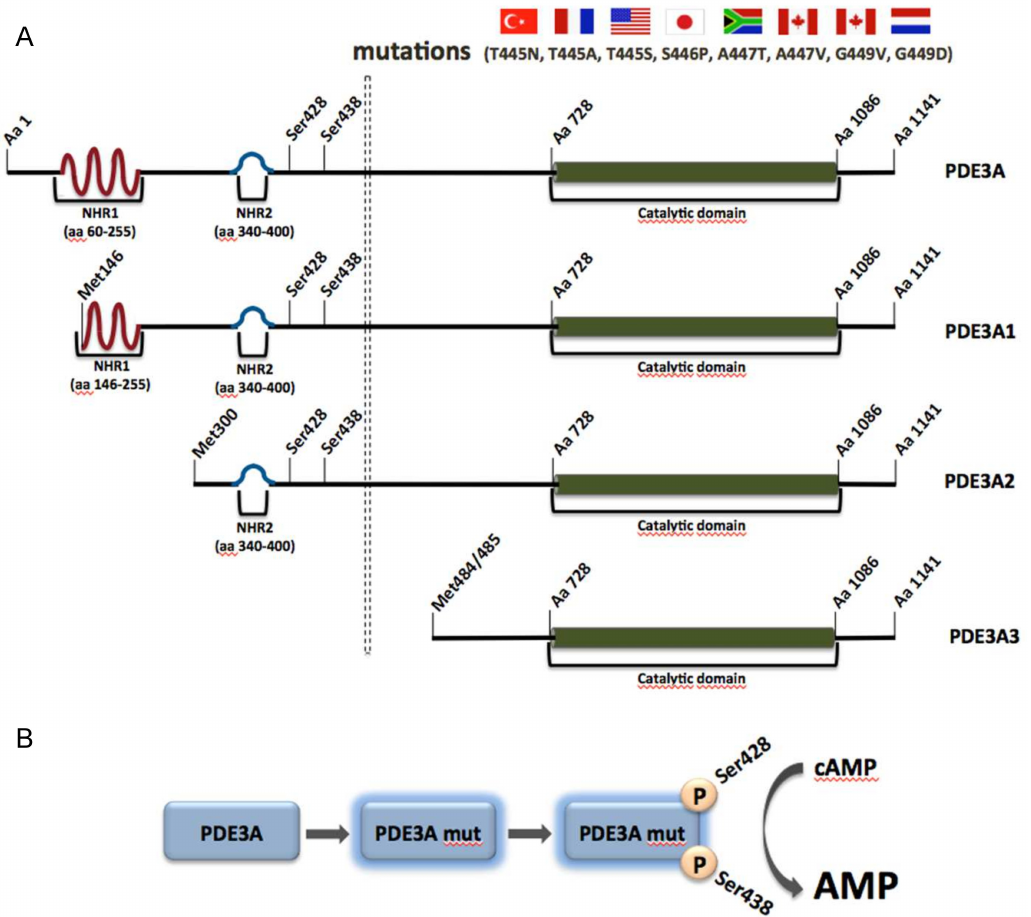
Figure 3. Schematic representation of the PDE3A gene, PDE3A protein isoforms and the hyperphosphorylation caused by the identified mutations. ( A ) Eight mutations have been identified in families from the countries indicated by the flags. The mutations cluster within a region of the gene encoding amino acids 445 and 449. The mutations cause hyperphosphorylations of Ser428 and Ser438. The N-terminal hydrophobic region (NHR) 1 of PDE3A1 comprises four transmembrane domains, while NHR2 contains no typical transmembrane region but a cluster of hydrophobic amino acids. PDE3A2 contains only NHR2 and PDE3A3 lacks all N-terminal hydrophobic regions (for details see text). ( B ) The hyperphosphorylation increases cyclic adenosine 3 (cid:48) -5 (cid:48) monophosphate (cAMP) hydrolysis, causing low cAMP